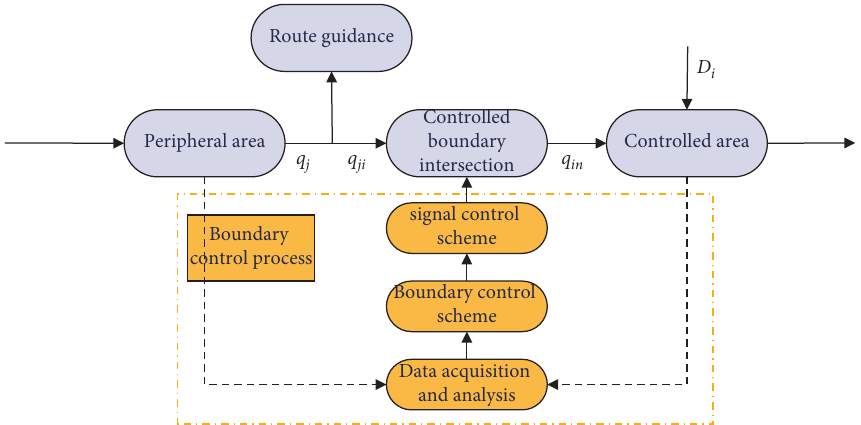
Figure 5: Schematic diagram of the boundary control